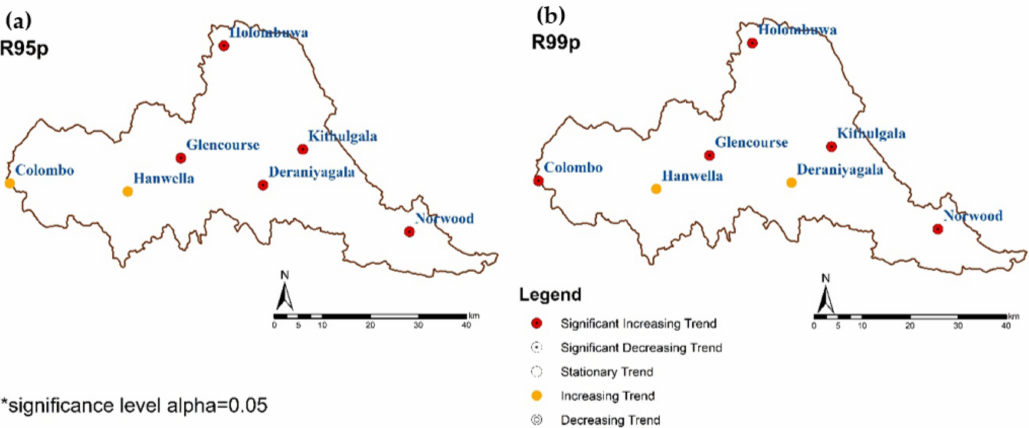
Figure 9. The spatial and temporal variability of the trend of station-related threshold EPIs in the last 40 years period in the study area: ( a ) R95p and ( b ) R99p. Non-threshold EPIs (PRCPTOT, Rx1day, Rx5day, and SDII) had a similar spatial